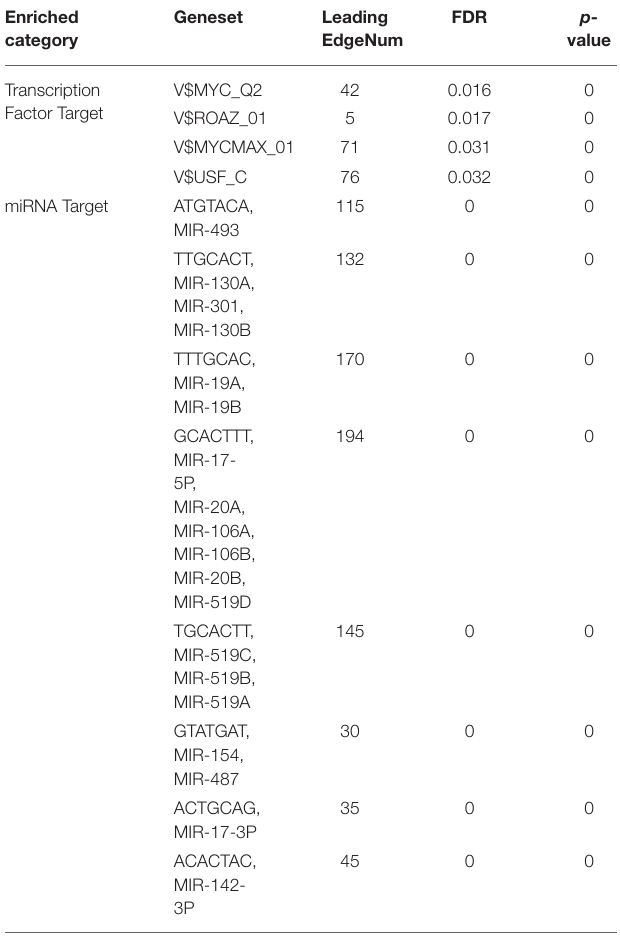
TABLE 4 | The transcription factor- and miRNA-target networks of CORO2A in breast cancer (LinkedOmics). Enriched category